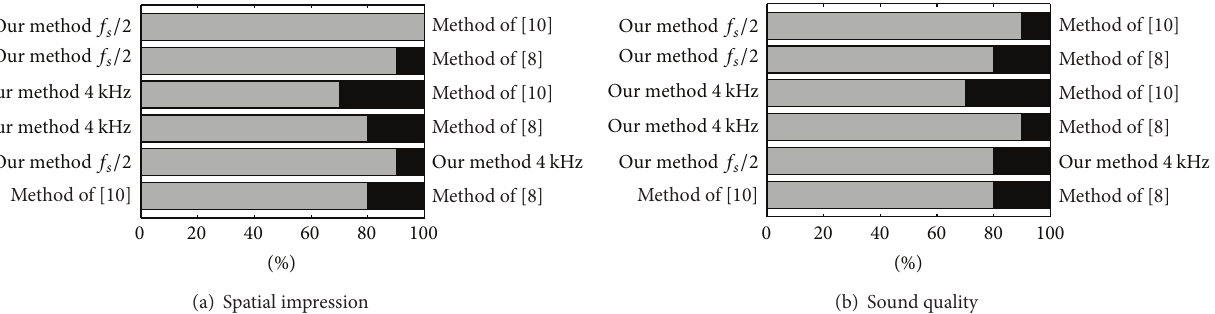
Figure 11: Preference listening test results for the speech recording with loudspeaker reproduction.